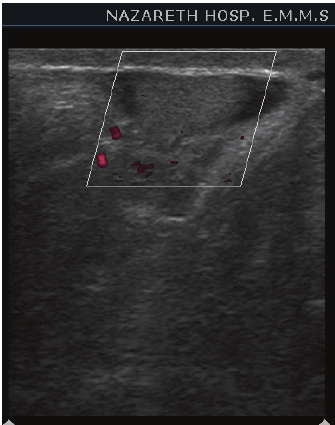
Figure 1: Ultrasound color Doppler of the inguinal area shows an inguinal oval 1.6cm, hypoechogenic mass with no flow in it that resembles small testis.